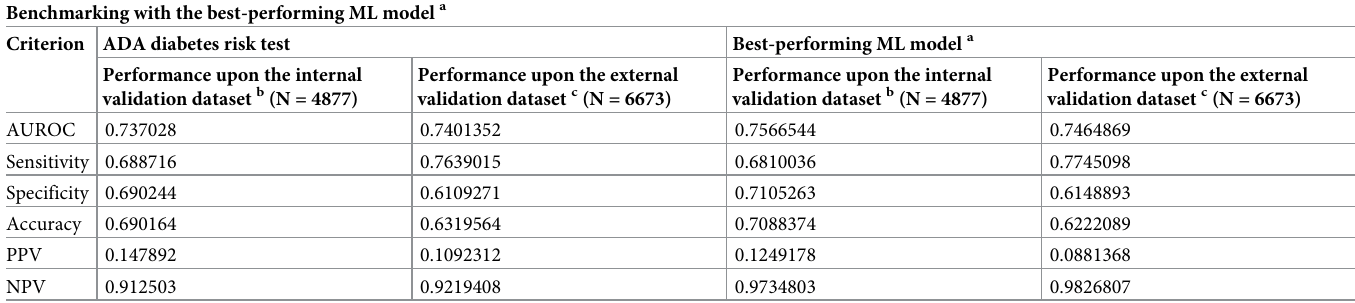
Table 4. Performance comparison of the ADA diabetes risk test versus the best-performing model on NHANES data. Benchmarking with the best-performing ML model a